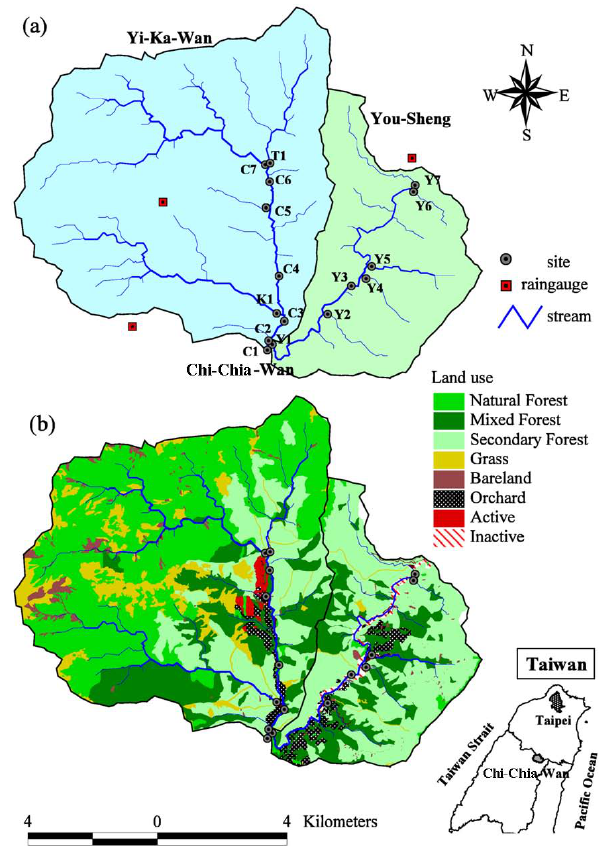
Fig. 1. Landscape (a) and land use pattern (b) in the study area.